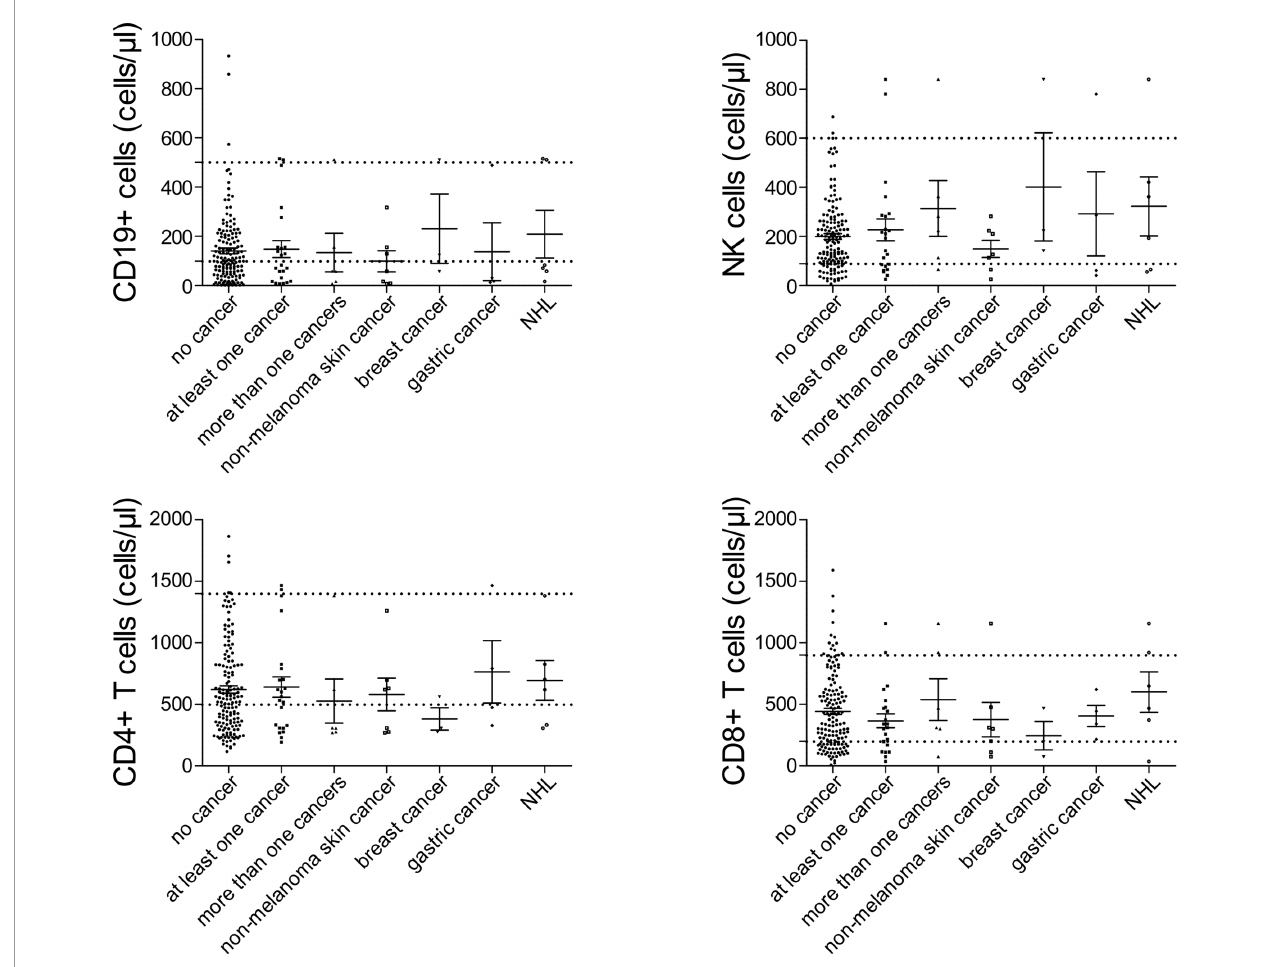
FIGURE 2 | Peripheral lymphocyte subset counts at diagnosis of common variable immunode fi ciency (CVID) in patients with no cancer ( N = 192), patients with at least one cancer ( N = 27), more than one type of cancer ( N = 6), non-melanoma skin cancer ( N = 7), breast cancer ( N = 7), gastric cancer ( N = 6), and non-Hodgkin lymphoma (NHL, N = 6). No signi fi cant differences could be